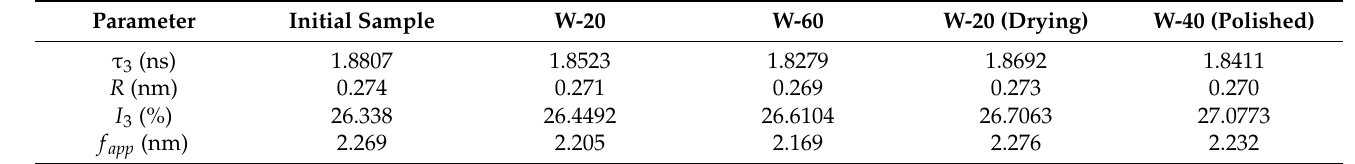
Table 4. Free volume change of epoxy resin after the water absorption saturation at different temperatures.